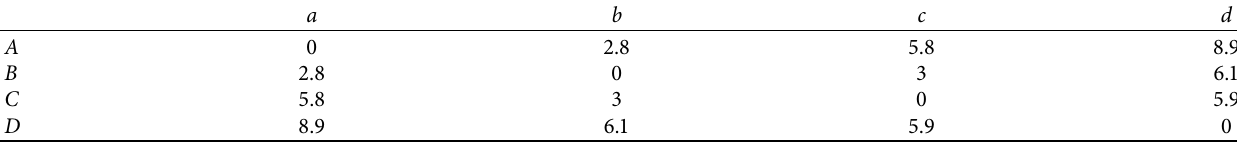
Table 1: Distance between equal probability symbols.